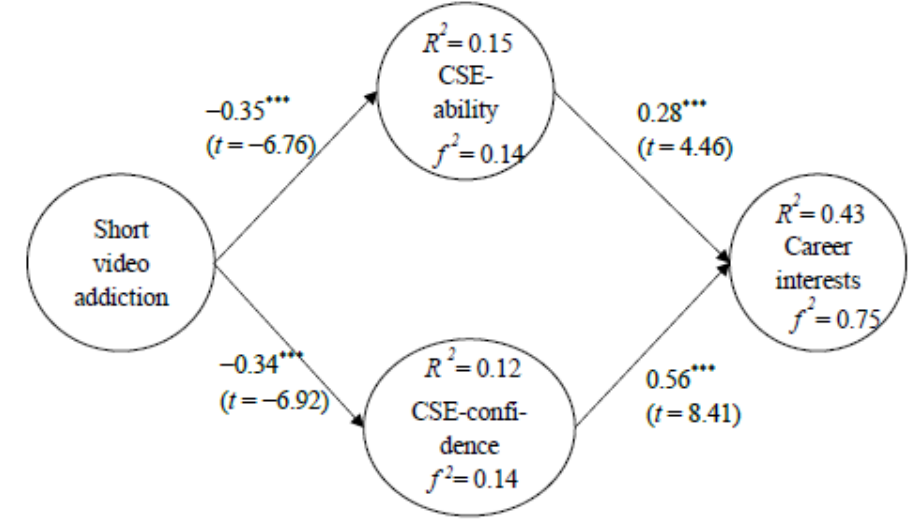
Figure 2. Validation of research model. *** p < 0.001.